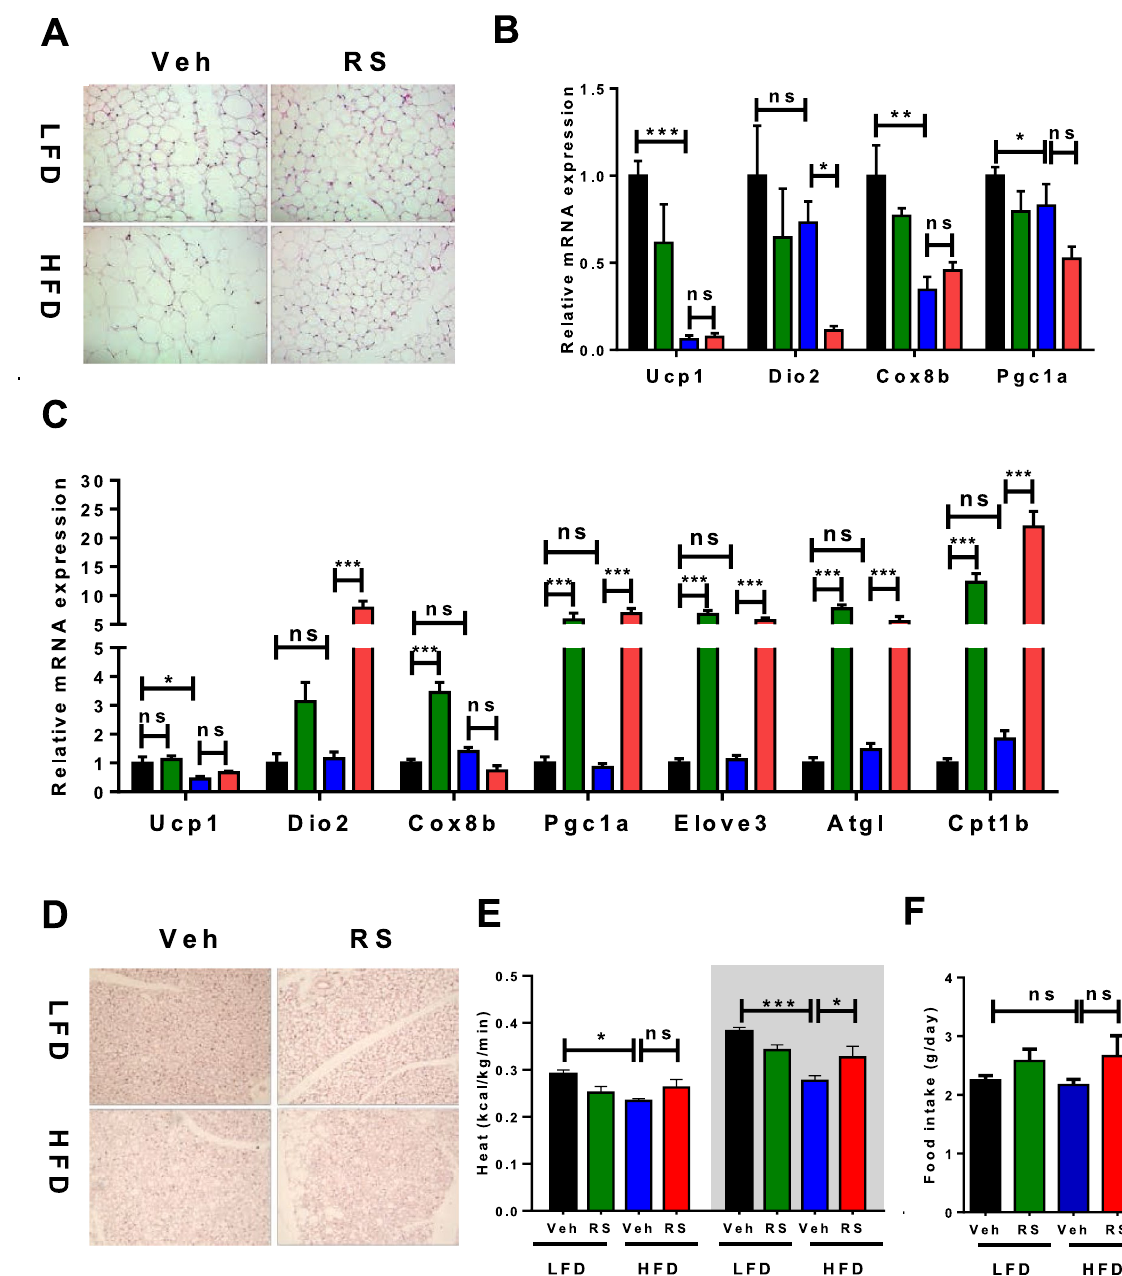
Figure 3. Roscovitine prevents diet-induced hypertrophy of iWAT and induces a thermogenic program in BAT without enhanced UCP1 expression. Analysis of iWAT and BAT in 19–20 weeks LFD and HFD fed male mice treated for last 6 weeks with roscovitine or vehicle. ( A ) Representative pictures of H&E-stained subcutaneous adipose tissue (iWAT) cross sections. ( B ) mRNA expression level of thermogenic genes in iWAT (n = 5 / group). ( C ) mRNA expression level of thermogenic genes in BAT (n = 5/group). ( D ) Representative pictures of H&E- stained brown adipose tissue (BAT) cross sections. ( E ) Heat production during 12 h light (left) and dark (right) cycles measured by CLAMS (n = 5 / group). ( F ) Cumulative food intake of mice in CLAMS (n = 5 / group). Data were analyzed and illustrated using GraphPad Prism 6.0 software (GraphPad, https:// www. graph pad. com). All values are expressed as means ± SEM; *p < 0.05, **p < 0.01, and ***p <